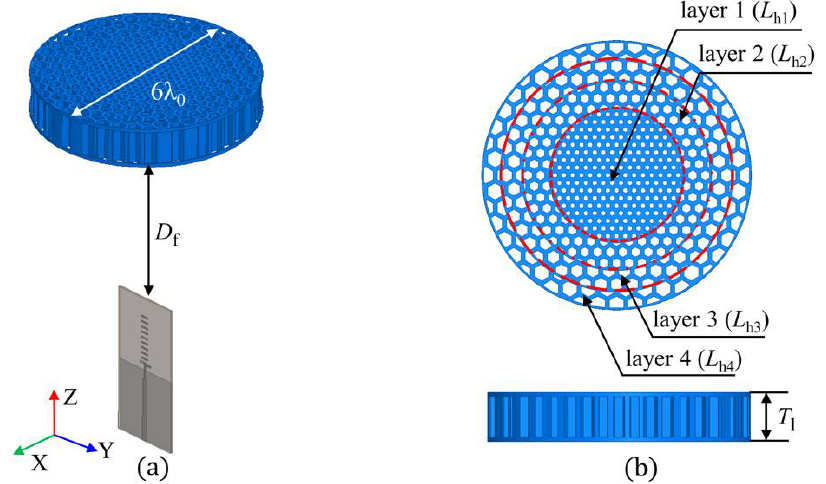
Figure 5. ( a ) Source antenna integrated with GRIN lens; ( b ) fractal GRIN lens with honeycomb cells top and side view.